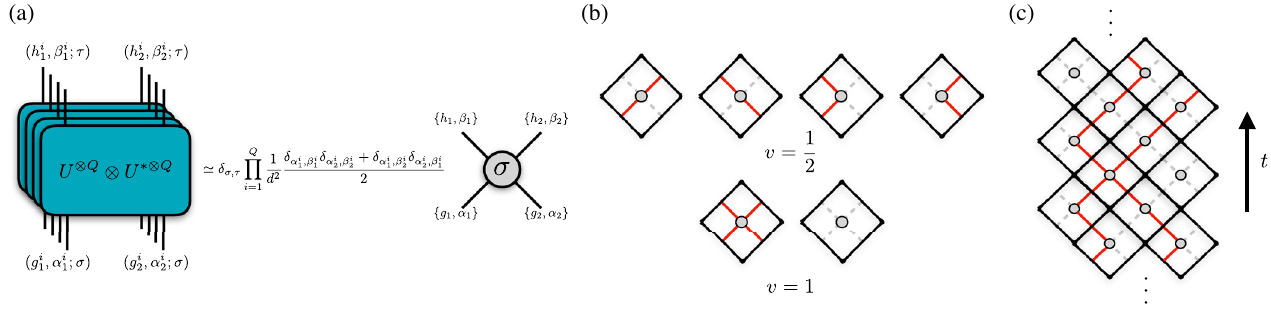
FIG. 6. Statistical mechanics model. (a) The average of U ¼ U ⊗ Q ⊗ U (cid:4) ⊗ Q over Haar gates is nonzero if and only if the conjugate (bra) replicas are permutations of the nonconjugate (ket) replicas. Hence we can conveniently write each leg in the circuit as a set of Q copies of nonconjugate states combined with a permutation group element [see Eq. (A1)]. In the large- d limit, the permutation group elements for ingoing and outgoing legs become locked together in a single permutation, and the corresponding permutation group element σ can be associated with a vertex (one per gate), while the charge states live on links. The U(1) charges α , β are constrained by charge conservation. (b) The charge dynamics in each replica are given by an effective 6-vertex model with weights v , corresponding to a symmetric exclusion process constrained by the measurements and entanglement cut. (c) Example of charge